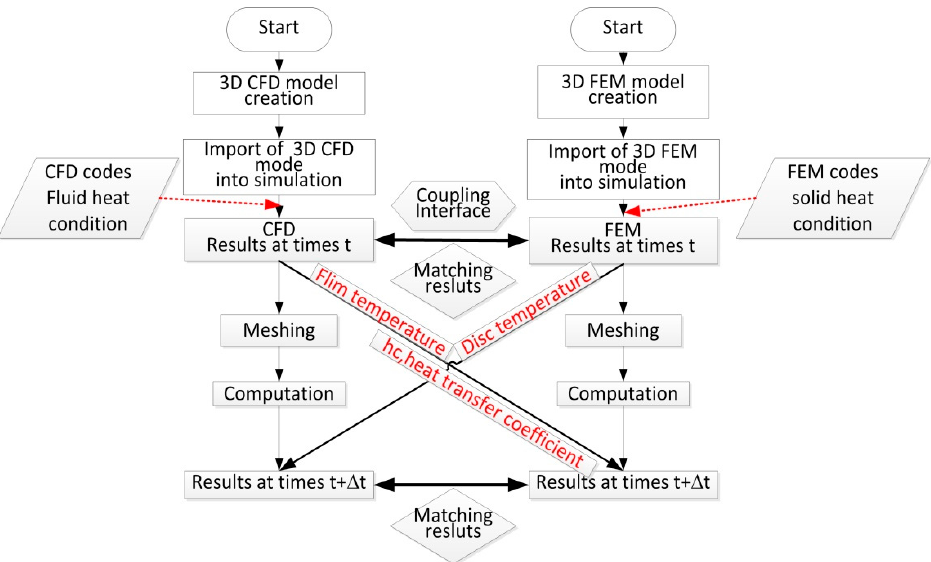
Figure 5. Finite element method (FEM)-CFD coupling calculation flow chart of disc brake.